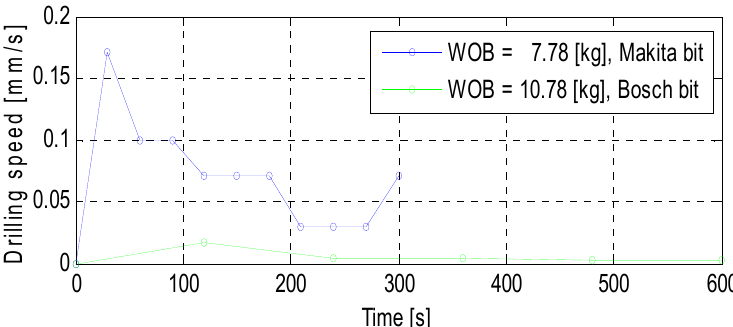
Figure 8. Drilling speed during drillability test performed for Szydłowiec sandstone A—soft sample with motor’s power supply voltage 24 V, Makita and Bosch coring bits, weight on bit (WOB) 76.32 N and 105.75 N, respectively.